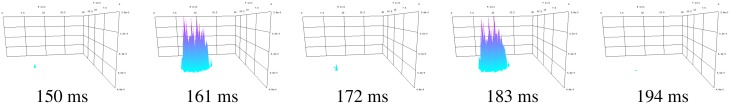
Two cycles of the breather oscillations.